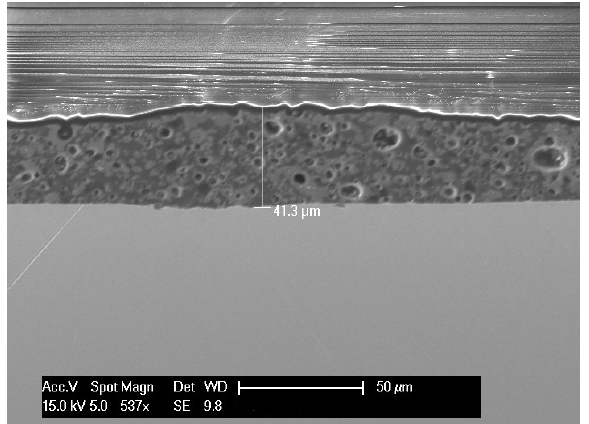
Figure 5 . A cross-sectional SEM image of the protective layer coated on 304L stainless steel substrate, crosslinked at 200 °C and pyrolyzed at 700 °C in argon .